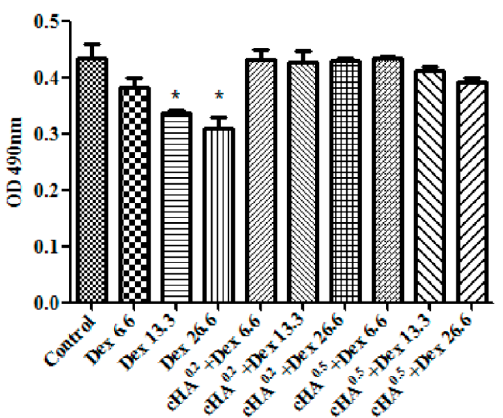
Figure 1. Cross-linked hyaluronic acid-dexamethasone (cHA-Dex) hydrogel exhibited low cytotoxicity compared with Dex only treatment in vitro . The influence of Dex, cHA-Dex (0.2 mg/mL) gel, and cHA-Dex (0.5 mg/mL) gel on the survival of human osteoarthritic chondrocytes was assessed using a methyl thiazolyl tetrazolium (MTT)-based colorimetric assay. Three Dex concentrations were tested, which were 6.6, 13.3, and 26.6 µg/mL. Data were expressed as means ± SD. * represents that the difference was statistically significant (* p < 0.05). n = 3.